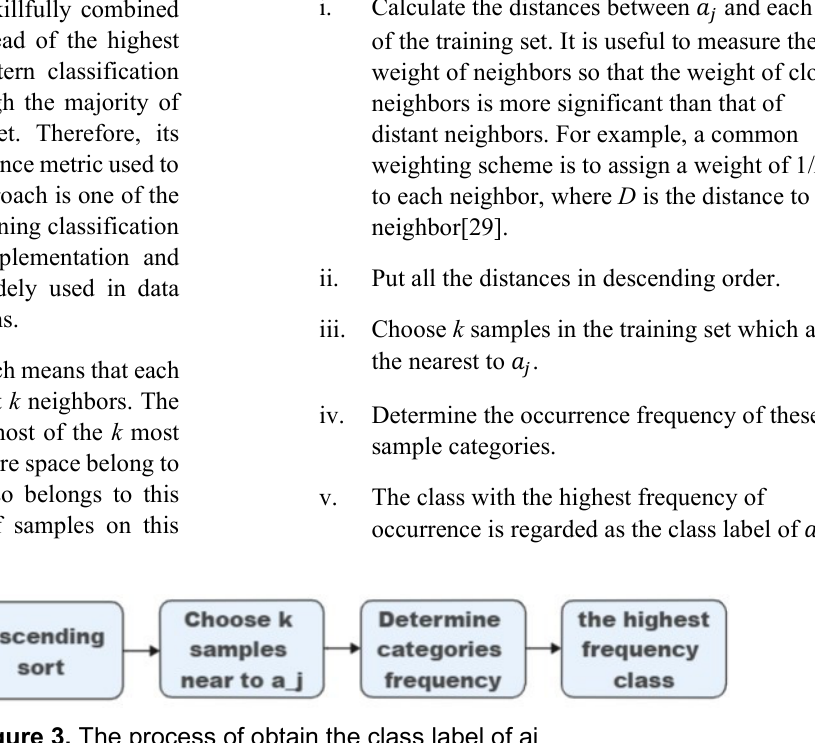
Figure 3. The process of obtain the class label of